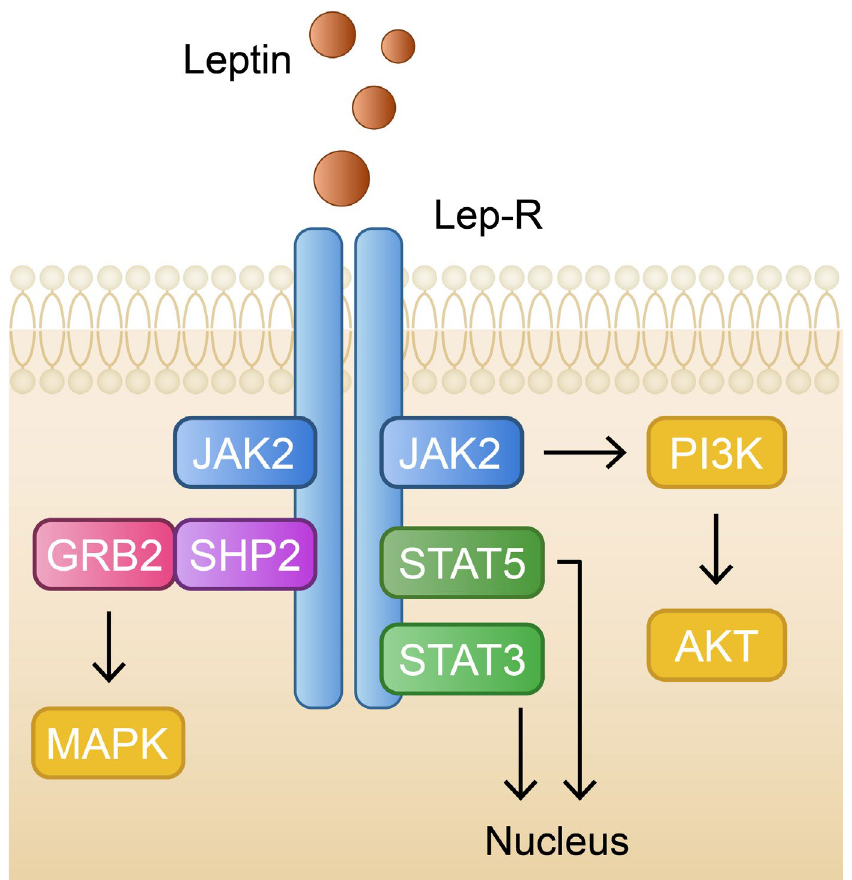
Figure 3. Schematic and simplified representation of the leptin signaling pathway. GRB2—growth factor receptor-bound protein 2; JAK2—janus kinase 2; MAPK—mitogen-activated protein kinase; PI3K—phosphoinositide 3-kinase; PIP2—phosphatidylinositol 4,5-biphosphate; SHP2—Src homology-2 domain-containing protein tyrosine phosphatase-2; STAT3—signal transducer and activator of transcription 3; STAT5—signal transducer and activator of transcription 5.